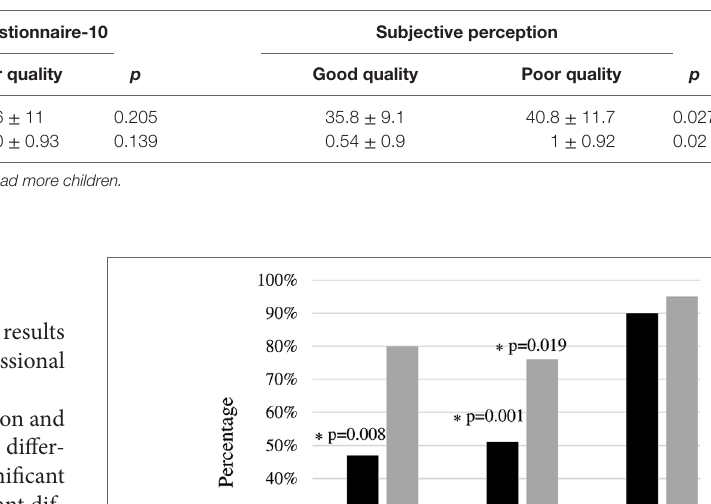
TaBle 1 | Relationship between sleep quality and personal and family characteristics.